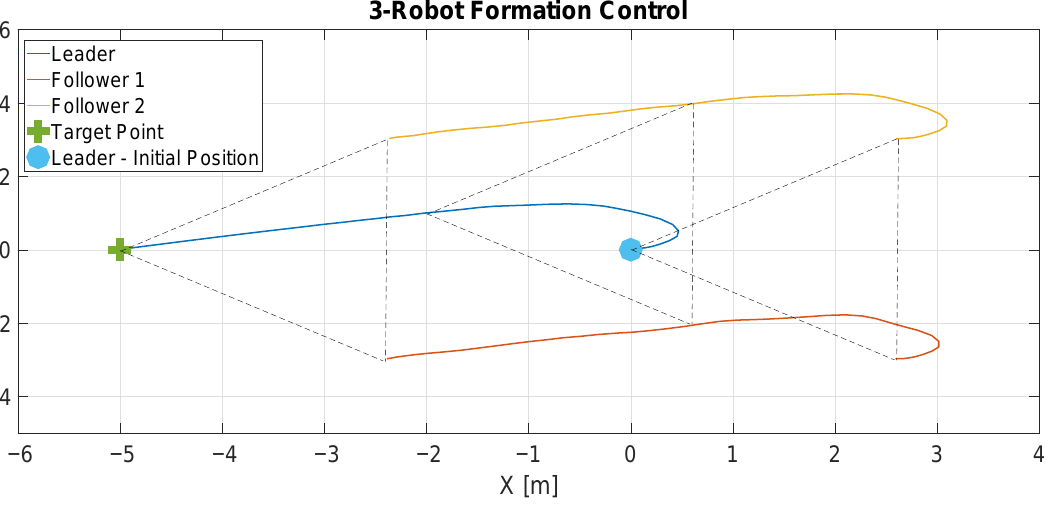
Figure 16. Results of the formation control experiment.